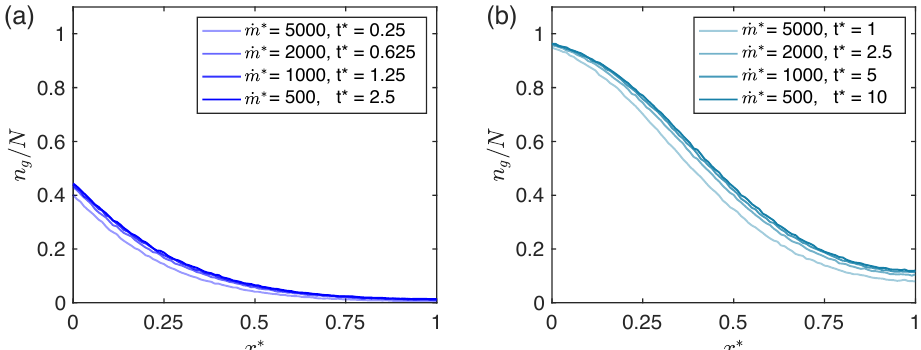
Figure 4. Dependence of Monte Carlo prediction on choice of ˙ m ∗ and t ∗ number of particles that have entered the system (at the time of observation) is held fixed, i.e., the